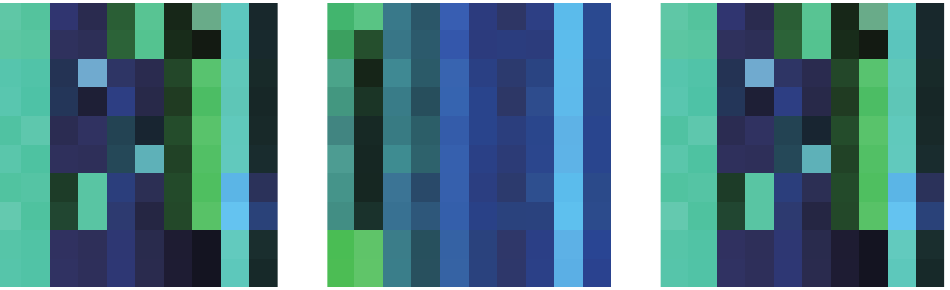
Figure 4. RGB images under different labels (Labels from left to right are ‘2-2’, ‘2-6’ and ‘2-10’